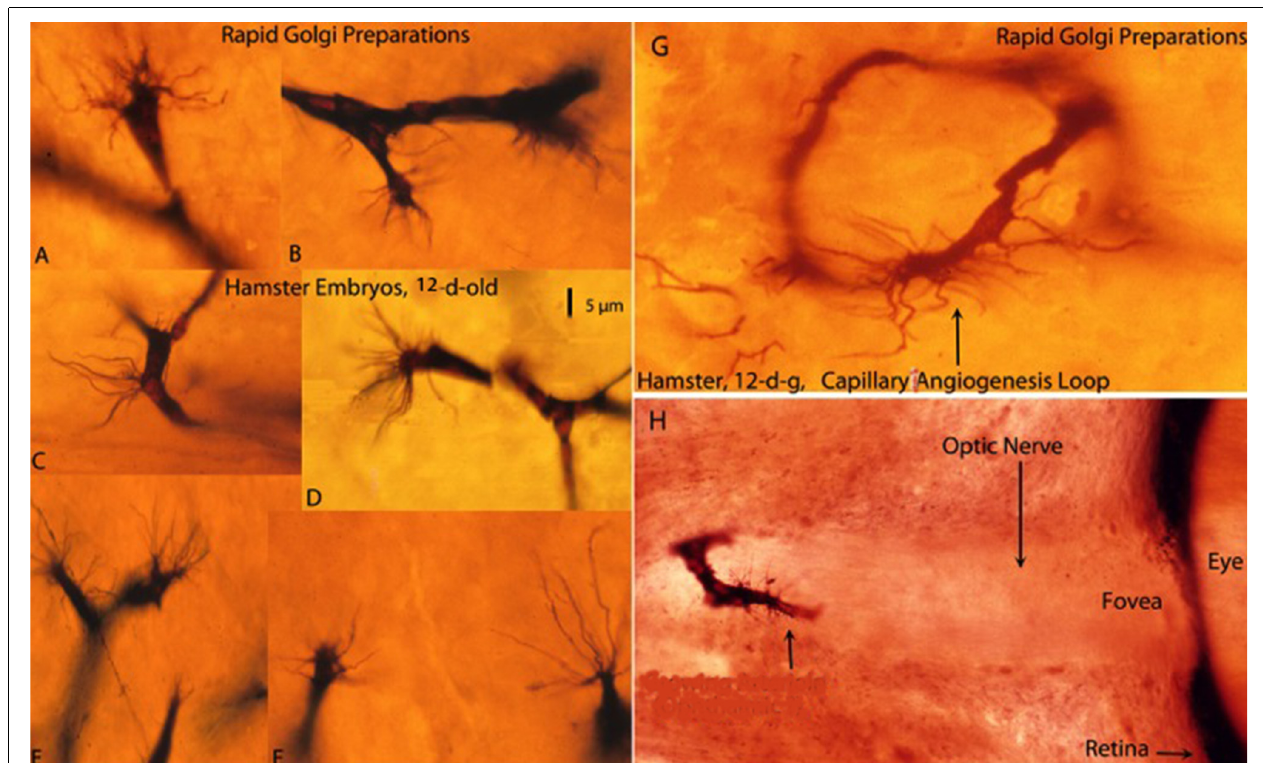
FIGURE 1 | Composite figure of rapid Golgi preparations showing growing capillaries in the cerebral cortex of 12-day-old hamster embryos. Growing capillaries have a polypoid head with numerous radiating filopodia (A,B,D–F) . (C) Detail of a new capillary growing directly from the vessel wall. (G) Detail of a newly established capillary loop with some peripheral filopodia that have not participated in the anastomotic process. (H) Detail of a growing capillary (arrow) with leading filopodia entering the optic nerve of a hamster embryo’ eye. The retina and the fovea are also shown. The 5 µ m scale (D) is roughly applicable to all capillaries of the figure excepting the eye’ one (H) , from Marín-Padilla